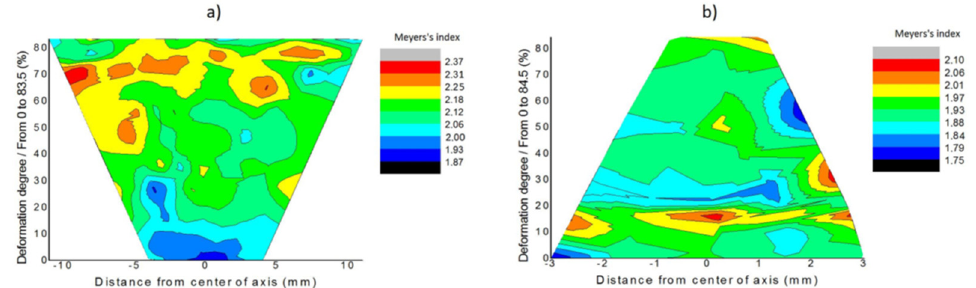
Figure 10. The dependence of the value of Meyer’s index on the position of the indentations and the degree of deformation for ( a ) the tensile piece and ( b ) the compressed samples.